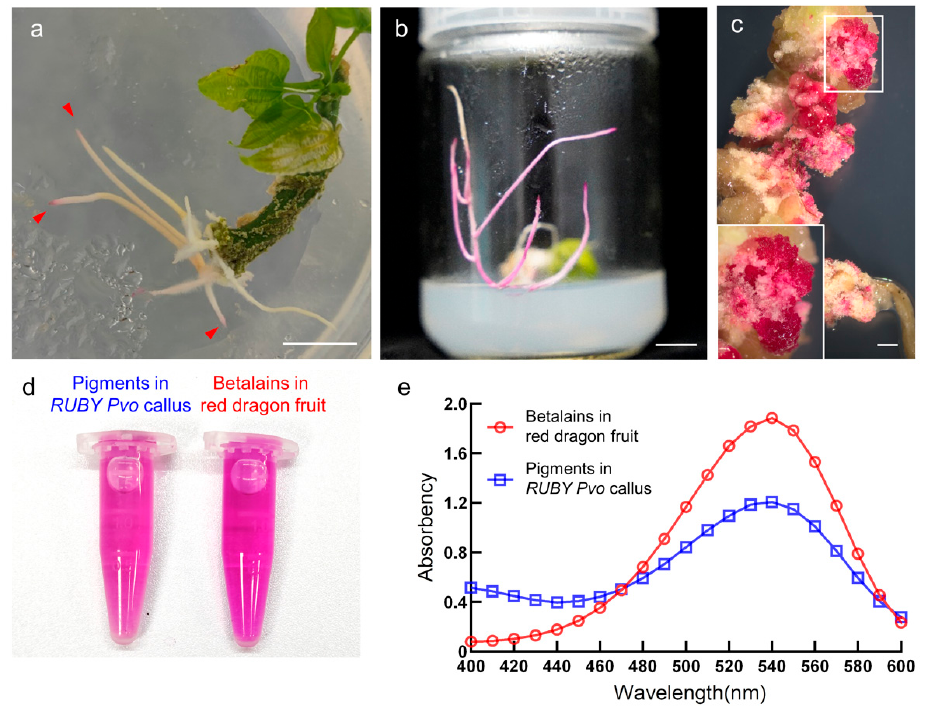
Figure 1. Induction of RUBY transgenic hairy roots and callus of P. volubilis and pigment identifica- tion. ( a ) DR5::RUBY transgenic hairy roots, the red triangles indicate the RUBY -colored root tips. ( b ) 35S 346 bp ::RUBY transgenic hairy roots. ( c ) Red callus induced from RUBY transgenic hairy roots of P. volubilis . The inset in the lower left corner is an enlarged image of the white box in the upper right corner, showing red callus induced from RUBY transgenic hairy roots. ( d ) Extracted pigment from RUBY callus of P. volubilis and red dragon fruit. ( e ) Absorption spectrum of the pigment from transgenic RUBY callus of P. volubilis and red dragon fruit (scale bar = 1